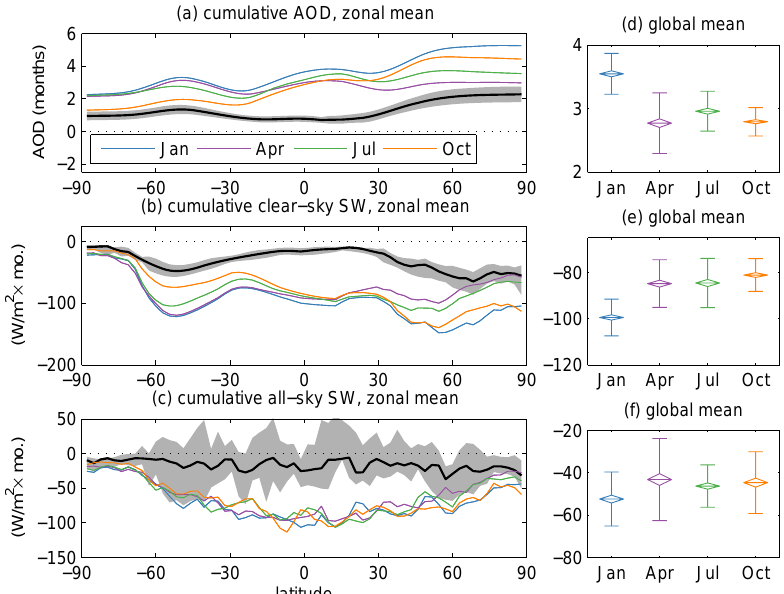
Fig. 5. Zonal mean (left) and global mean (right), four-year-cumulative post-eruption anomalies in AOD (top), clear-sky surface shortwave radiation anomalies (middle) and all-sky surface shortwave anomalies (bottom) for the E17 experiment. Eruption seasons indicated by colors. Black lines in zonal mean plots show mean difference between maximum and minimum response at each latitude, with shading indicating 95% confidence interval of difference based on the student’s t-test. In global mean plots, horizontal lines within diamonds indicates ensemble mean, vertical range of diamonds indicates standard error of mean, and vertical error bars indicate 2 σ ensemble